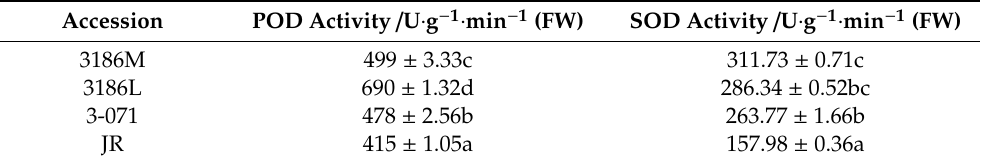
Table 3. POD and SOD activities of whitefly-treated tomato seedlings at the six-leaf stage. The measurements were made 2 weeks after treatment with whiteflies. Among them, a, b, c, and d represent di ff erent degrees of POD and SOD activities. The values represent the average of three technical replicates ± SD. 3186M (tomato wo mutant, hairy), 3186L (tomato wo mutant, hairless), 3-071 (tomato ln mutant, hairless), JR (tomato cultivar Jia Ren)